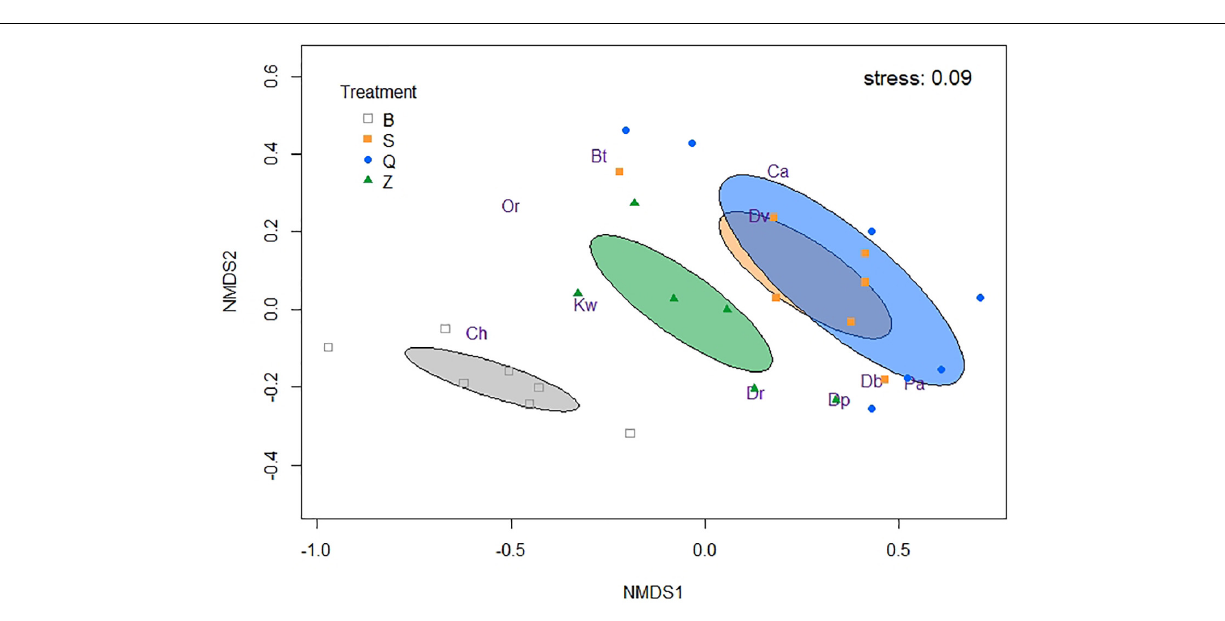
Frontiers in Ecology and Evolution |